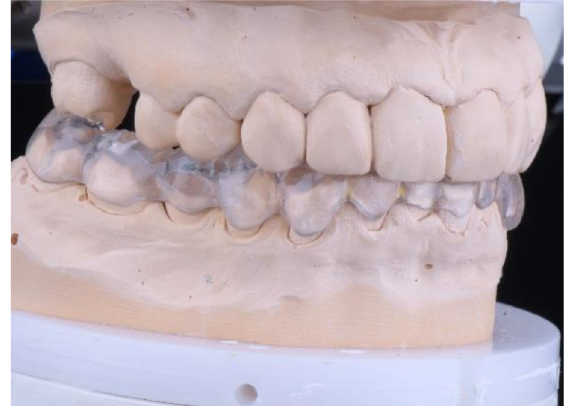
Figure 16. Splint on the